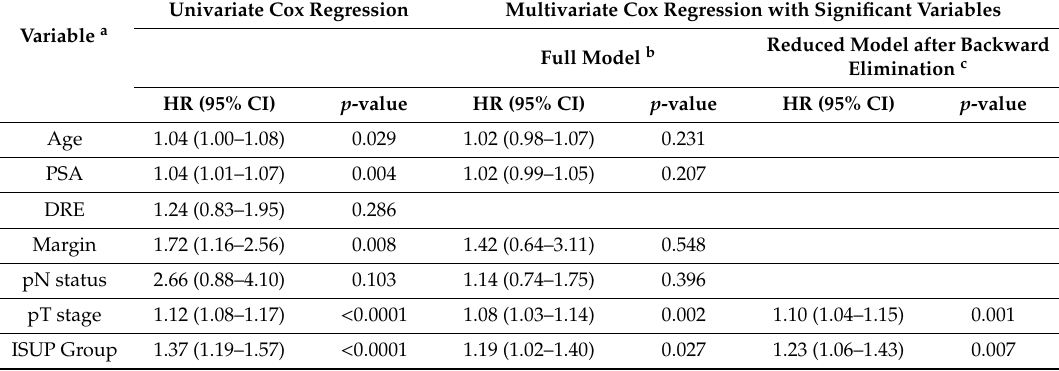
a Abbreviations and stratifications of the variables as indicated in Table 1; HR, hazard ratio. b The full model included all variables of the univariate Cox regression with hazard ratios and p -values < 0.200. c Reduced model after backward elimination with entry p < 0.05 and removal p > 0.100.